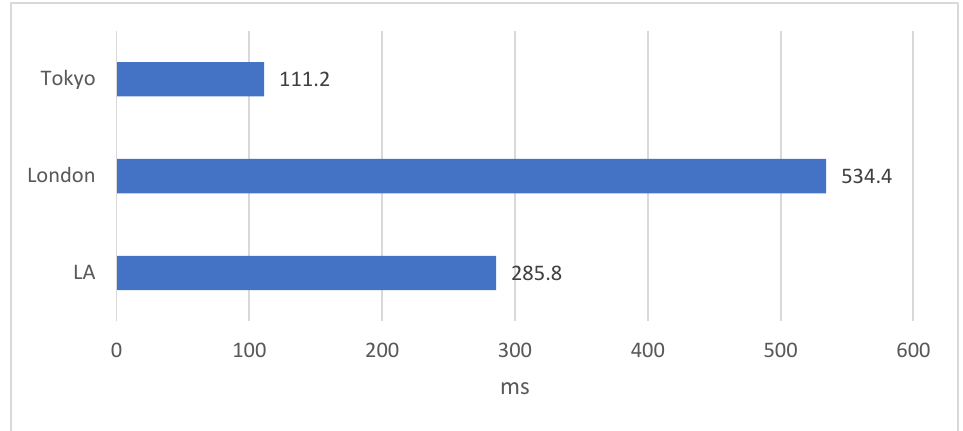
Figure 15. Cost of getting a peer list in the BT network.